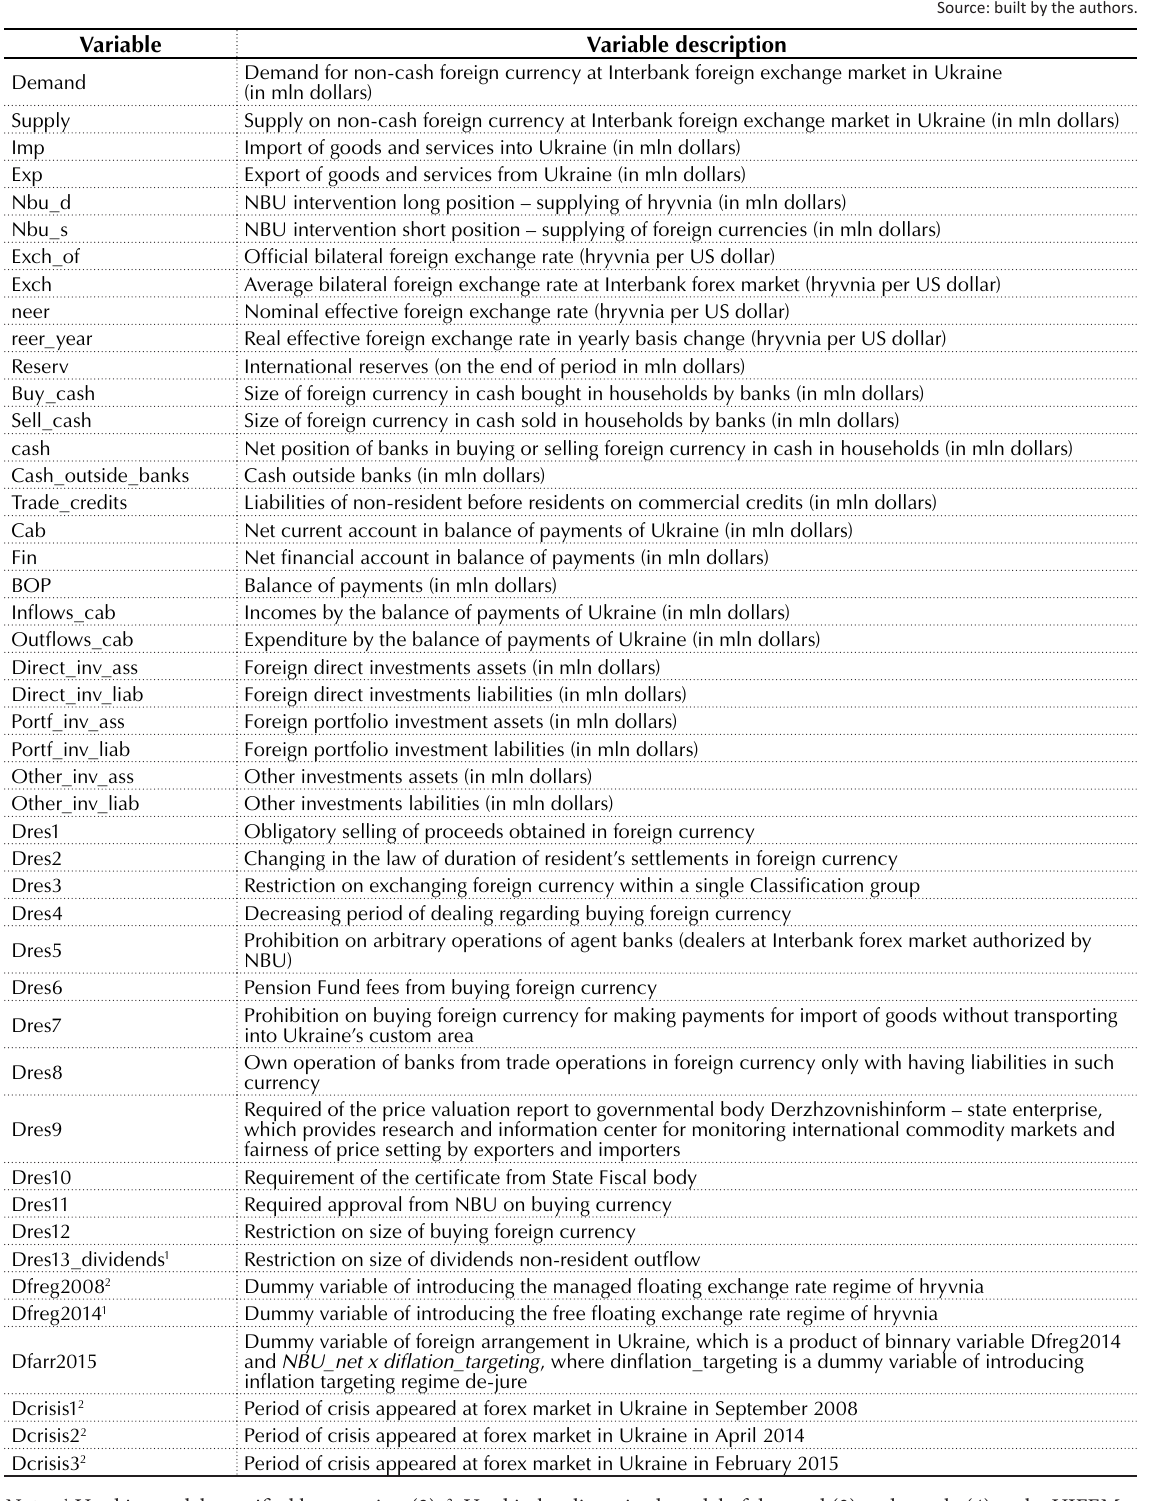
Table 1А. Description of data sample